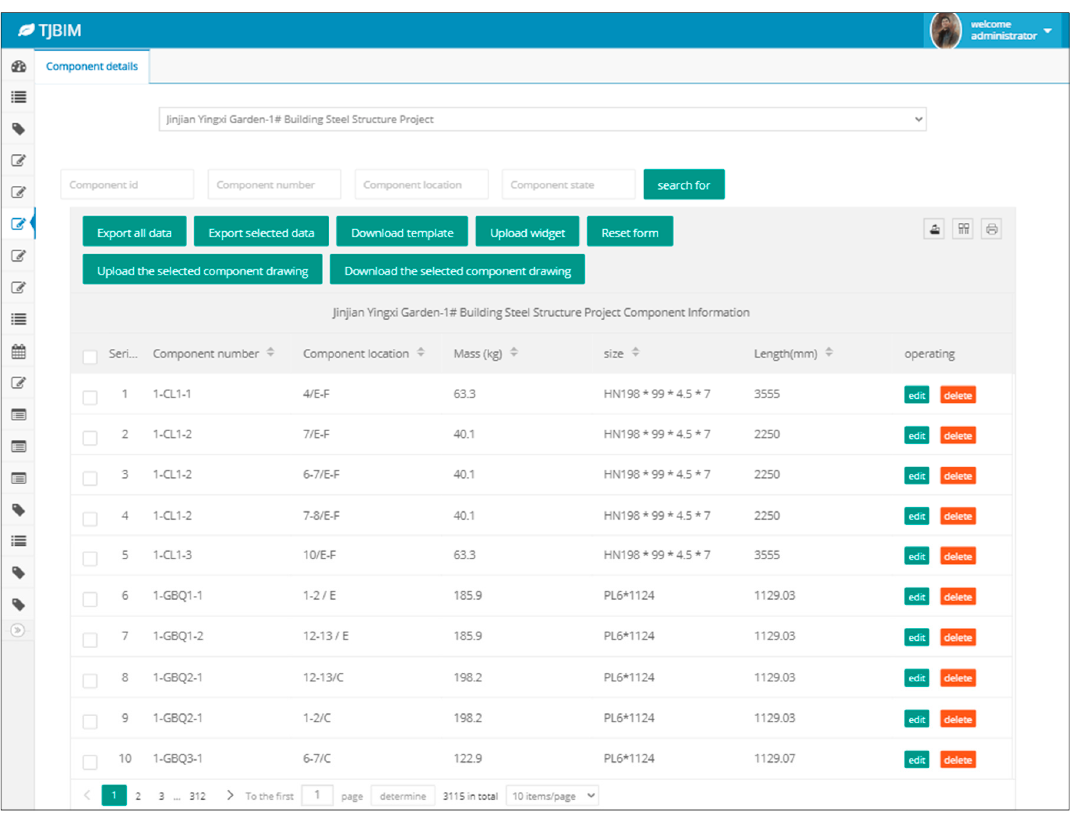
Figure 8. Detailed design.